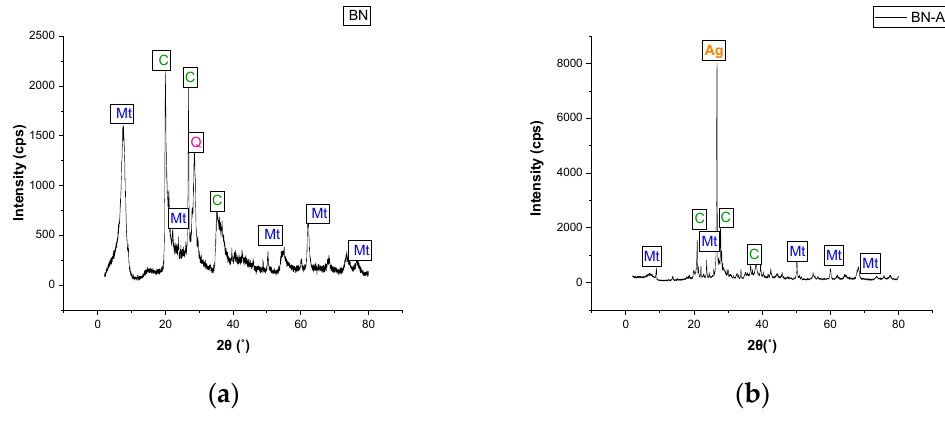
Figure 6. XRD diffractograms of BN ( a ) and BN-Ag 0 ( b ). Table 3. Quantitative analysis of BN-Ag 0 obtained by XRD. No.crt.